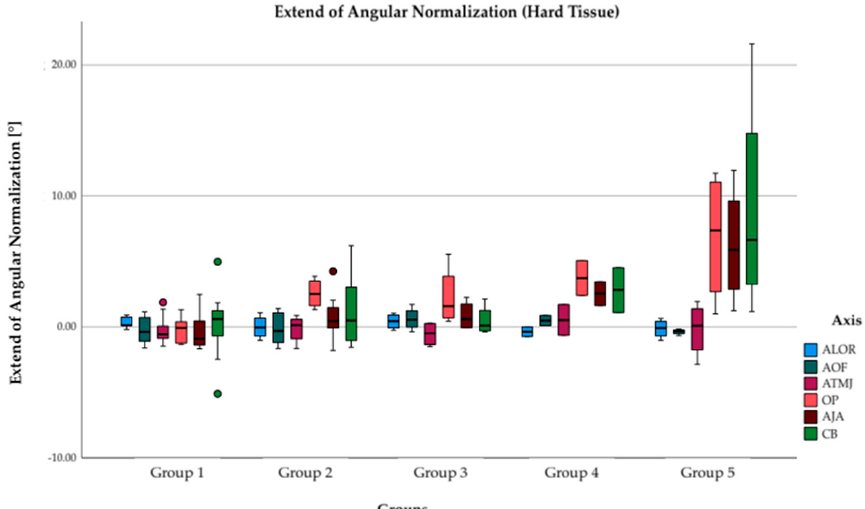
Figure 10. Extent of angular normalization in hard tissue after complete surgical treatment. Each column demonstrates mean values of angular changes in degrees of hard tissue after surgical treat- ment in each group. Mean values of preoperative and postoperative symmetry deviations were subtracted resulting in positive values for improvement and deterioration of symmetry. Both axis of lateral orbital rim (ALOR) (light blue), axis of orbital floor (AOF) (dark green) as well as axis of temporomandibular joints (ATMJ) (purple) show only few changes. Both axes occlusal plane (OP) (orange), axis of jaw angles (AJA) (dark purple), as well as chin base (CB) (green) show improvements in facial symmetry in group 2, 3, 4, and 5. However, largest improvements could be investigated in group